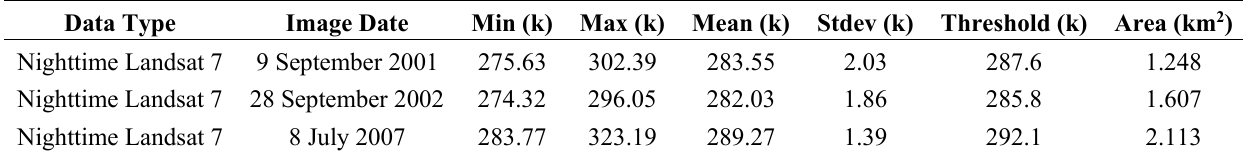
Table 3. Subsurface coal fires related thermal anomalies extracted from ETM+ thermal band 6